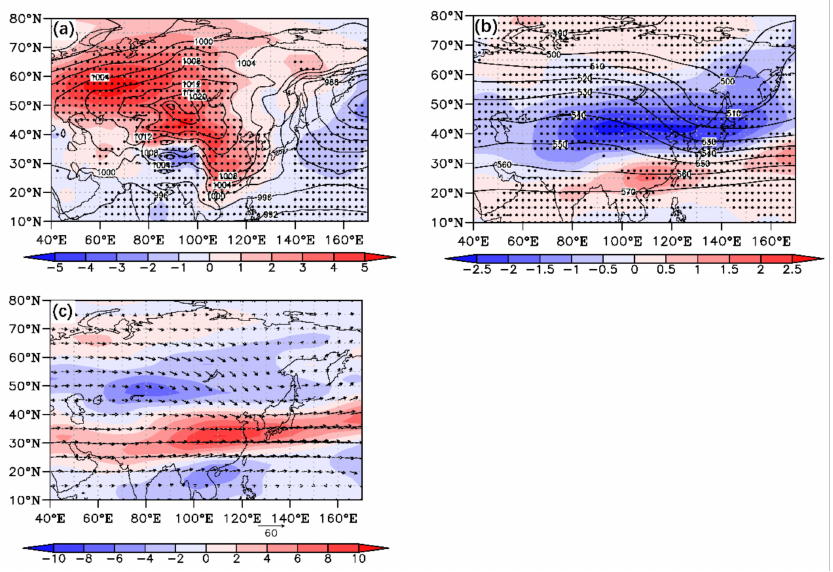
Figure 4. When WPECE occurs in key station: ( a ) SLP field (contour) and the corresponding SLP anomalies (shaded) (units: hPa); ( b ) 500 hPa geopotential height field (contour) (unit: gpm) and the corresponding air temperature anomalies (shaded) (units: ◦ C); ( c ) 300 hPa wind field (arrow) and zonal wind anomalies (shaded) (units: m/s) in WPECEs. The doted regions are for values significant at or above the 95% confidence